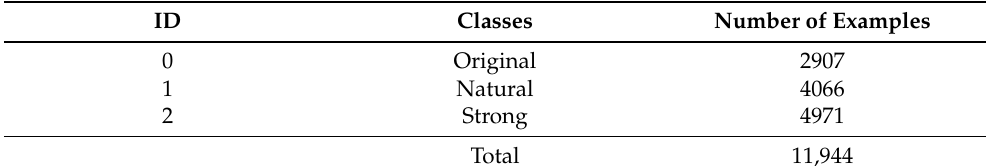
Table 6. PorSimples Corpus dataset.